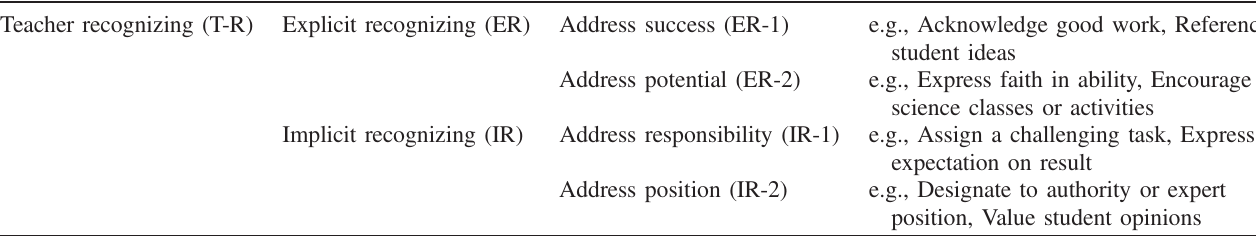
TABLE I. Codes for recognizing strategies. Teacher recognizing